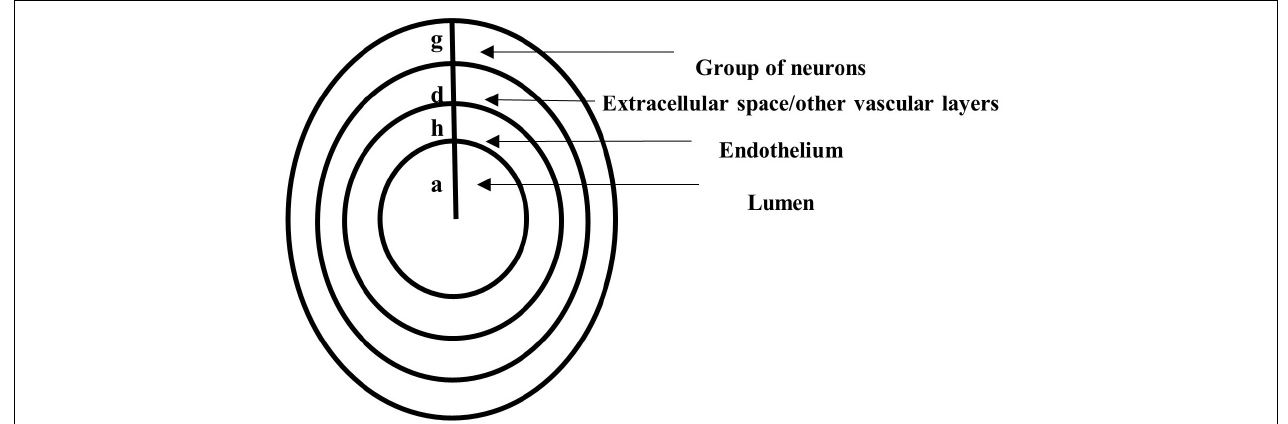
FIGURE 2 | A vertical cross-section through concentric horizontal axial symmetric circular cylinders representing the lumen of radius a , the endothelium of thickness h , a region of thickness d filled with other vascular layers and extracellular space, and a layer of thickness g occupied by